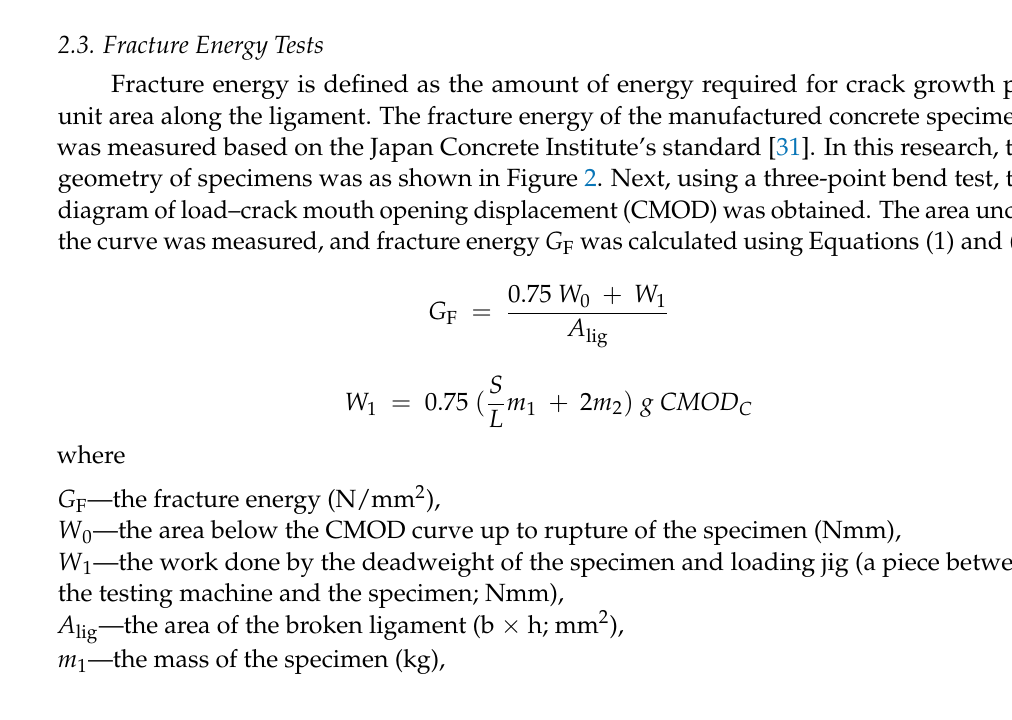
Table 2. Specifications of tested specimens.